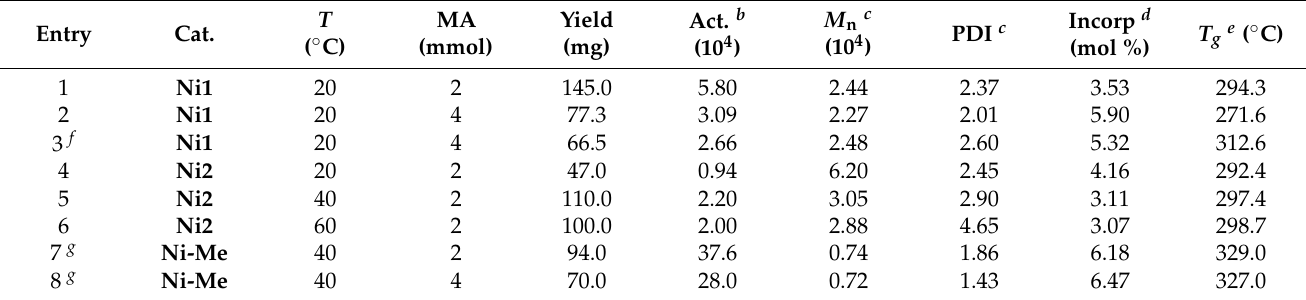
Table 2. Copolymerization of norbornene with MA by nickel complexes a